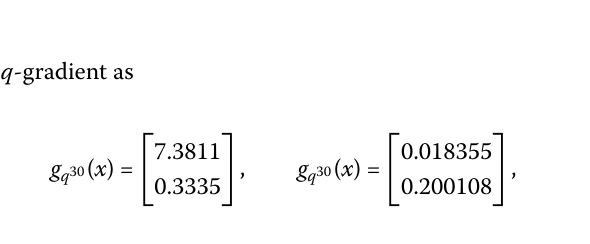
for x = (2,3) T and x = (–4,5) T , respectively, where